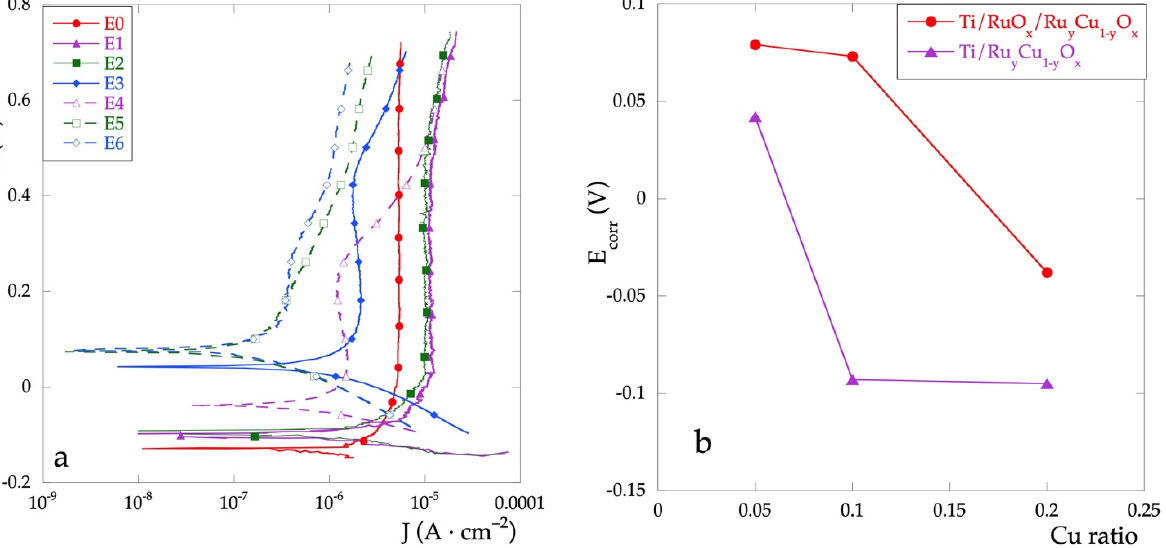
Table 2. Electrochemical data from EIS analysis.